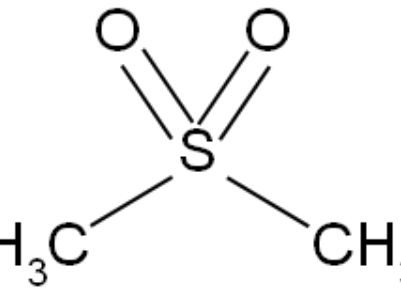
Figure 1. Structure of methyl sulfonyl methane.